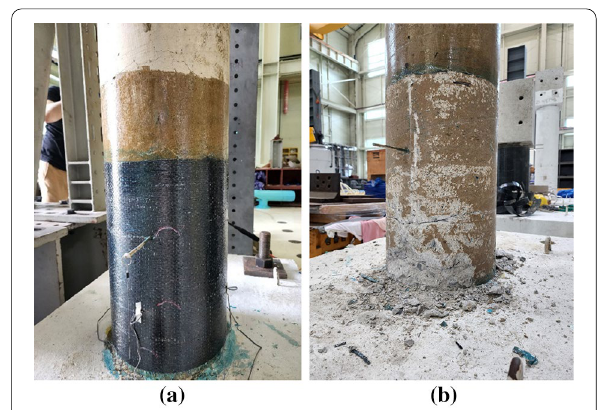
Fig. 14 CFRP specimen after failure: a with CFRP; b without